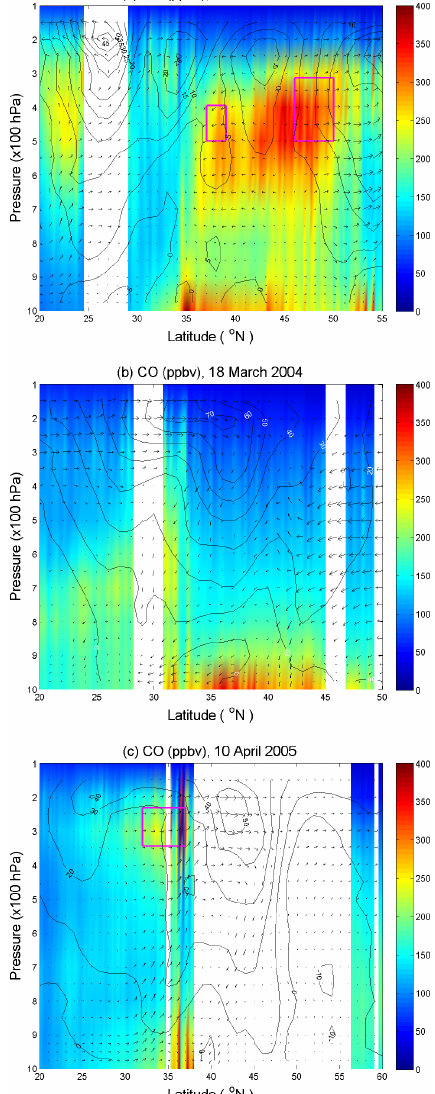
Figure 6. A latitude–altitude cross section of MOPITT CO aver- aged between the two blue dashed lines in Fig. 4 on (a) 6 June 2003, (b) 18 March 2004, and (c) 10 April 2005. The contour lines indicate U wind speed (ms − 1 ) . Vectors are for wind directions in V and W . For a better illustration, W is enlarged by a factor of 100. The pink box(es) in (a) and (c) indicate the locations where parti- cles were released and backward trajectories were simulated using FLEXPART (see text for detail).